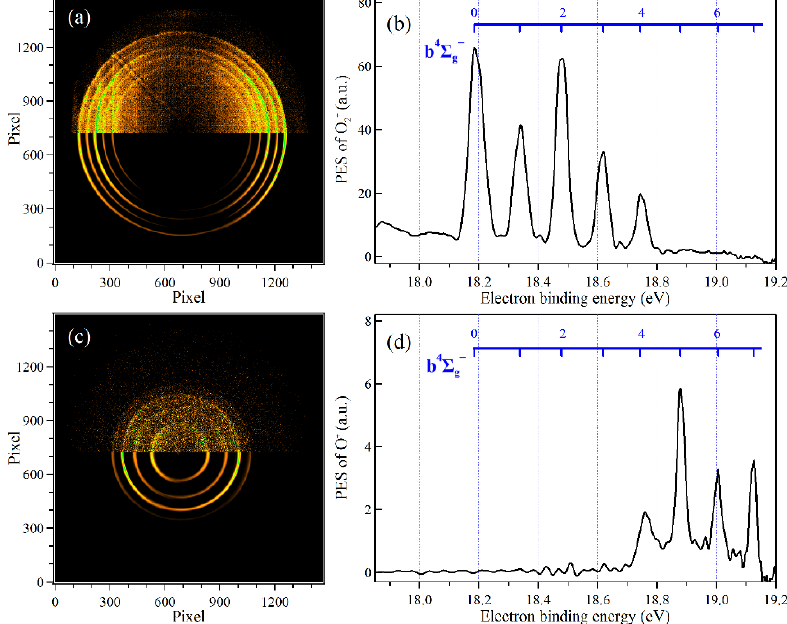
Figure 4. Mass-selected electron images and their corresponding photoelectron spectra, ( a , b ) the O 2 + parent ion, ( c , d ) the O + fragment ion, recorded at h ν = 19.2 eV.